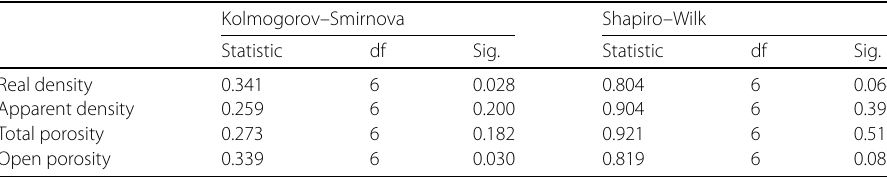
Table 2 The table of the normality test of the physical data Kolmogorov–Smirnova Shapiro–Wilk Statistic df Sig. Statistic df Sig. Real density 0.341